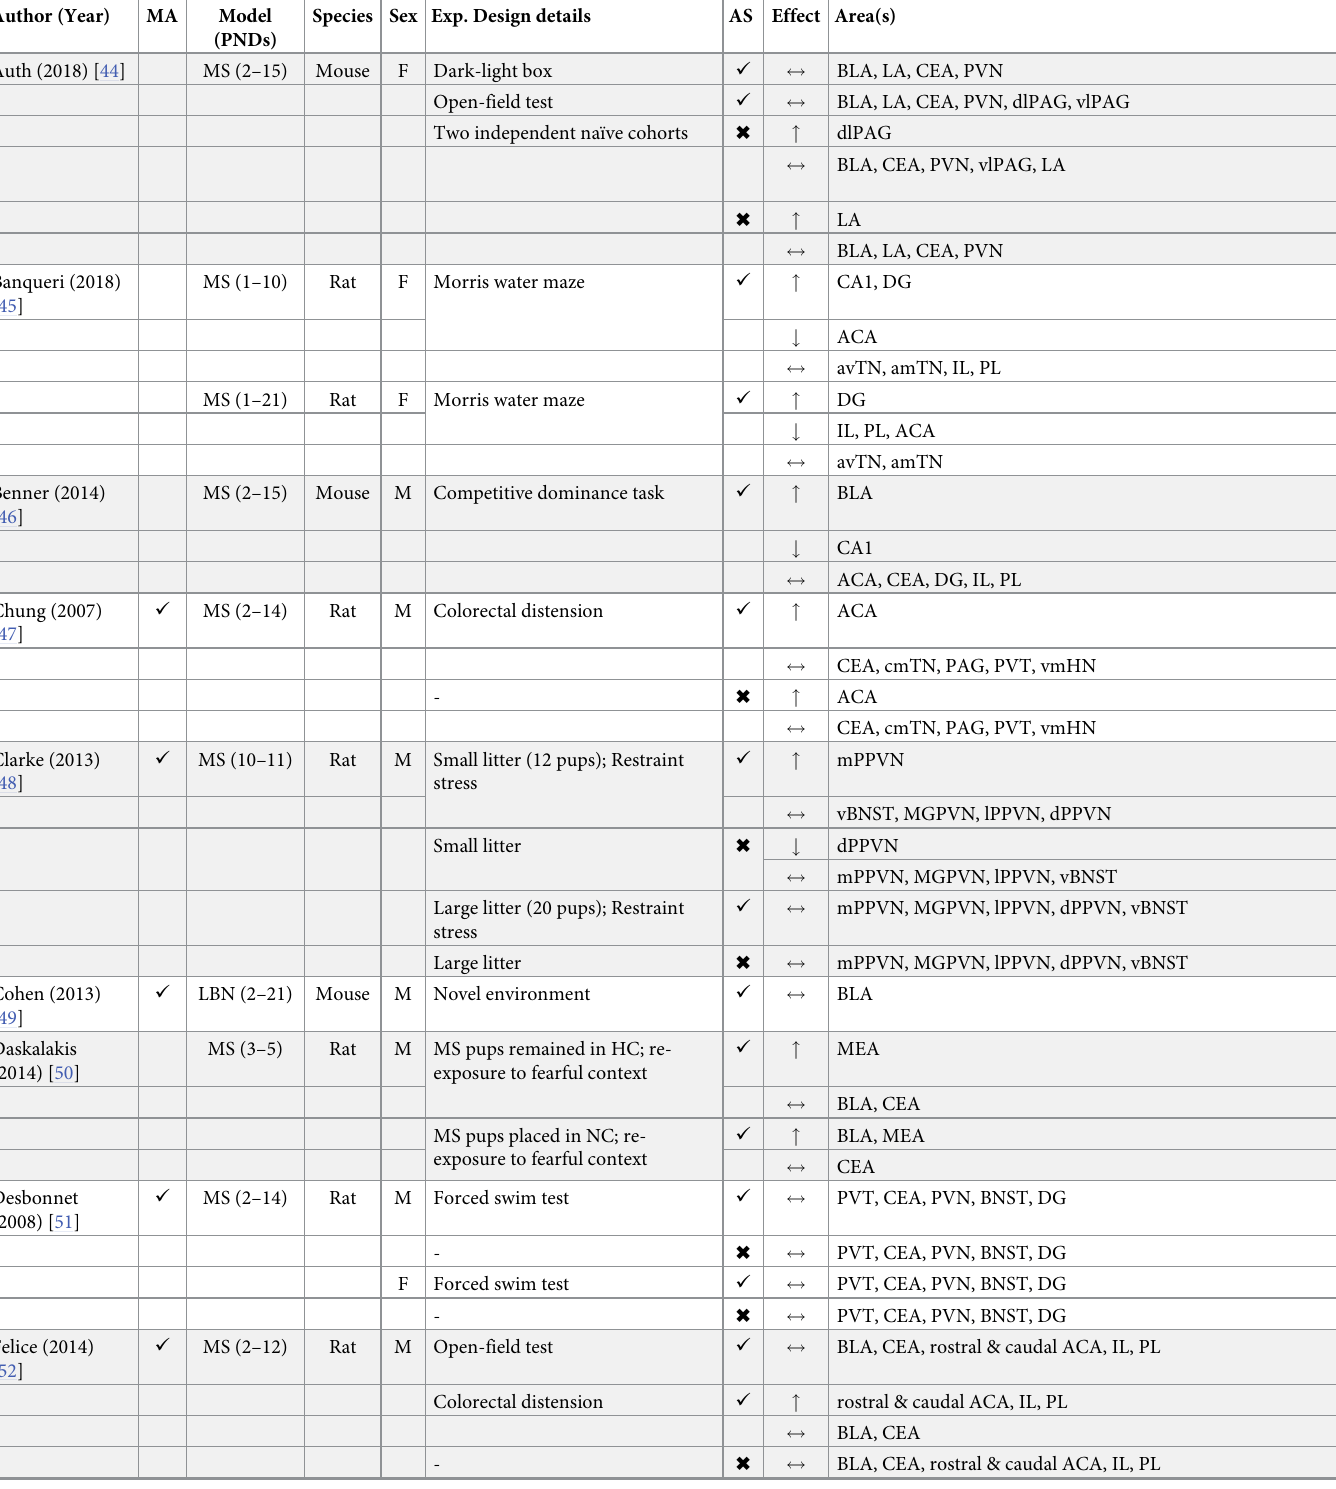
Table 1. Overview of study designs and findings of reviewed publications reporting on cFos expression in ELA and control